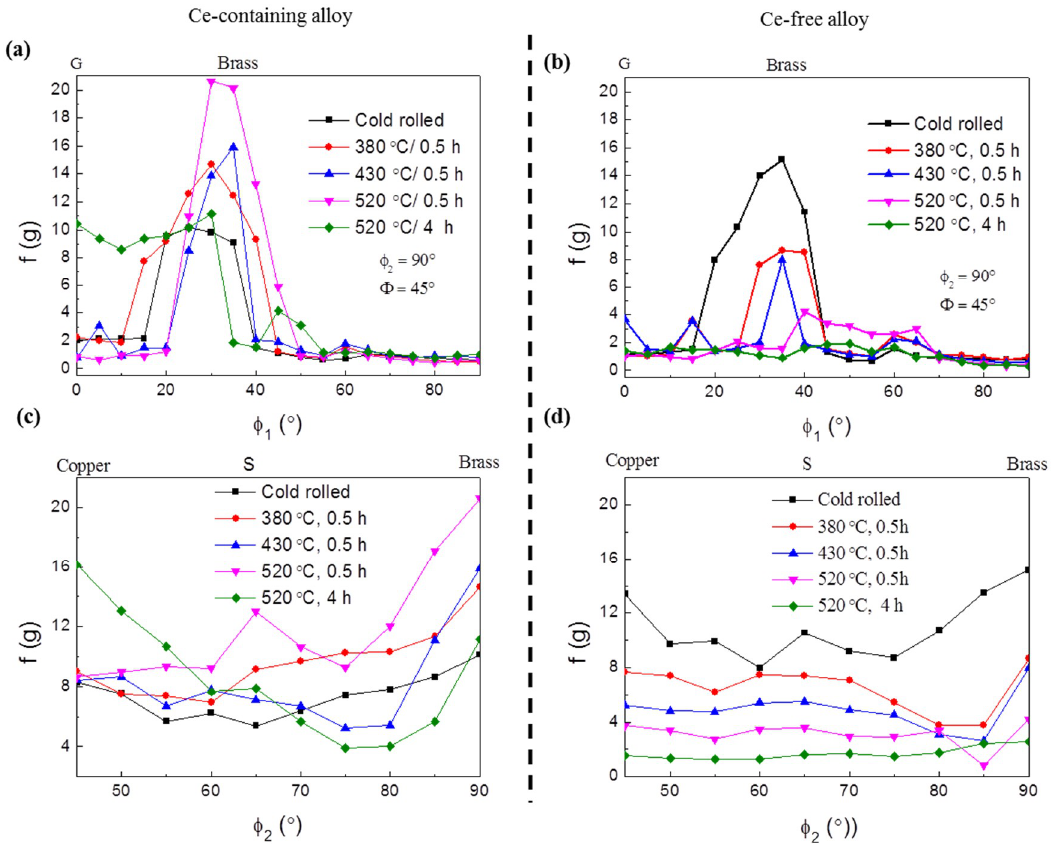
Figure 4. Texture evolution of the experimental alloys annealed under different annealing temperatures and time: ( a , b ) α-fiber; ( c , d ) β-fiber.